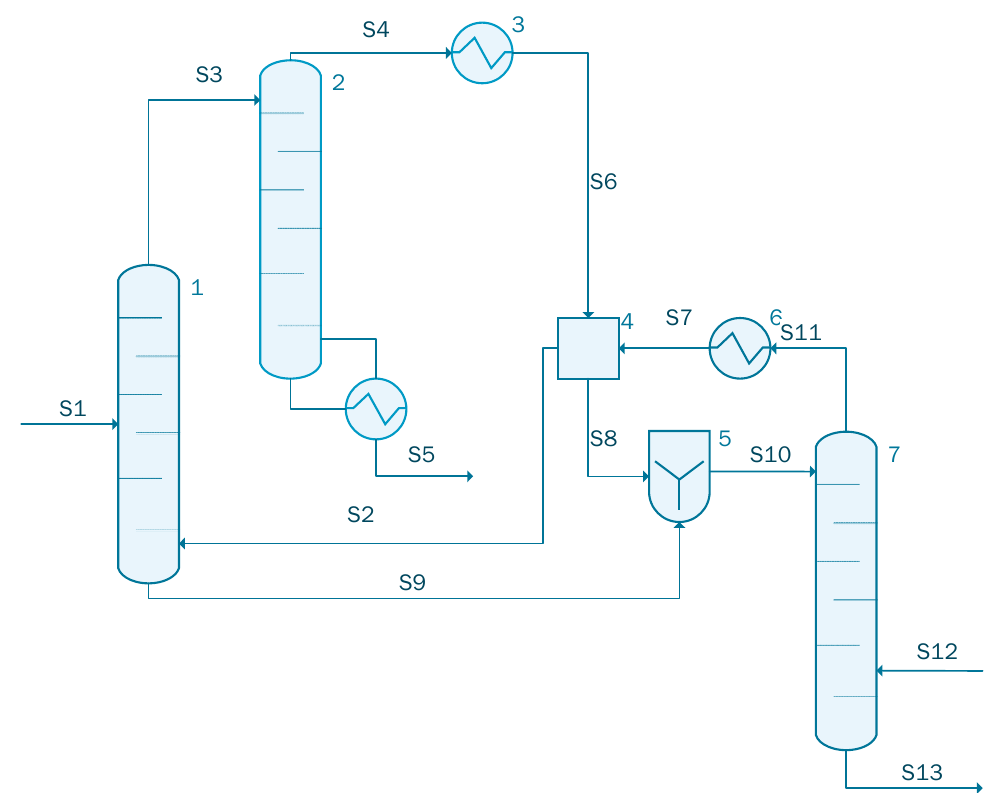
Figure 3. Process flow diagram for the acetic acid concentration process (case 1).